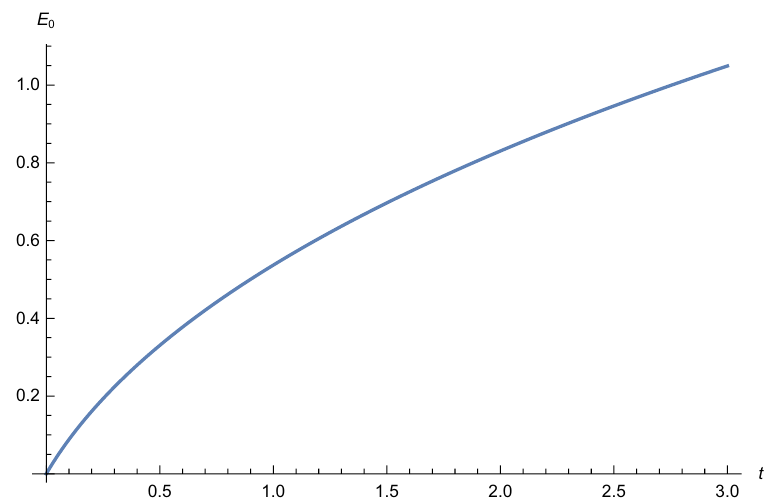
Figure 3. Plot of the threshold energy E 0 as a function of t = g s K . We set z = 1 in this figure.